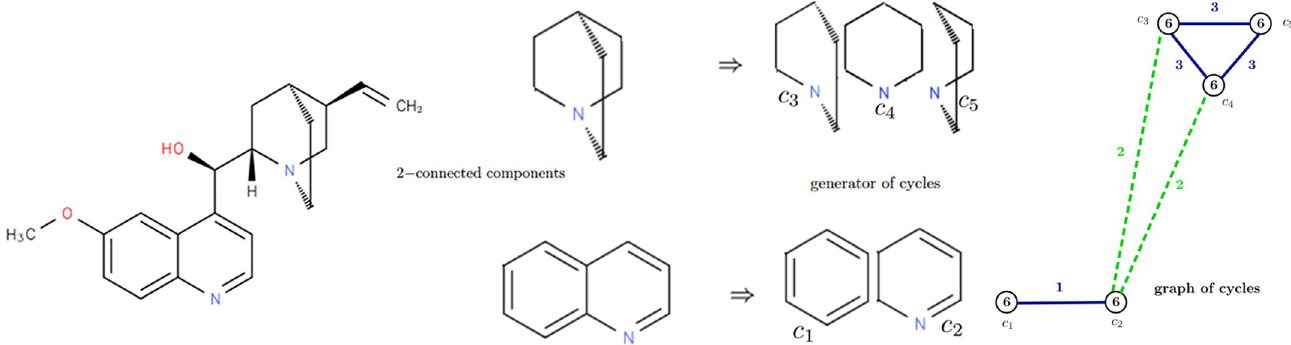
Fig 3. Quinine, 2 − connected components, elementary cycles and graph of cycles of quinine. From a graph, we obtain 2 − connected components by removing bridges. Then, using a minimum cycle basis, we build a graph of cycle representing the interaction between cycles in a molecular graph.